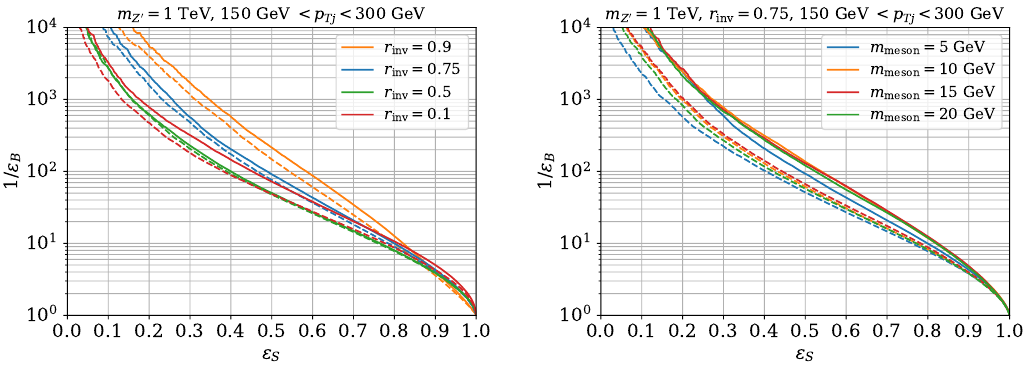
Figure 6: ROC curves (dashed lines) for the DGCNN trained on mixed samples of dark showers with different values of r each containing a specific value for r curves for training and testing on samples with identical parameters are shown for comparison (solid lines, as in figure